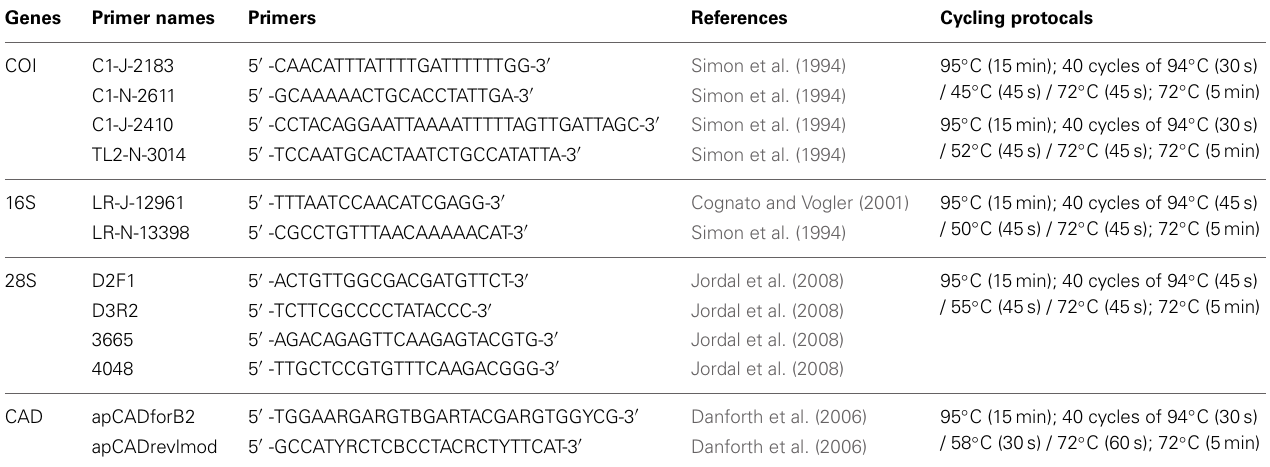
Table 2 | PCR primers and cycling regimes.